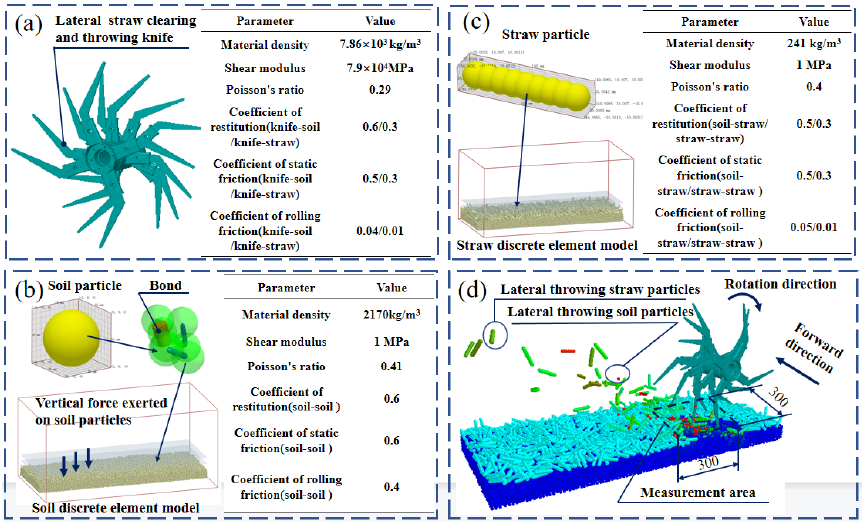
Figure 3. Discrete element simulation model construction and simulation. ( a ) Straw clearing knife roller model. ( b ) Soil particle discrete element model. ( c ) Straw particle discrete element model. ( d ) Straw clearing knife roller–straw–soil system discrete element simulation model.